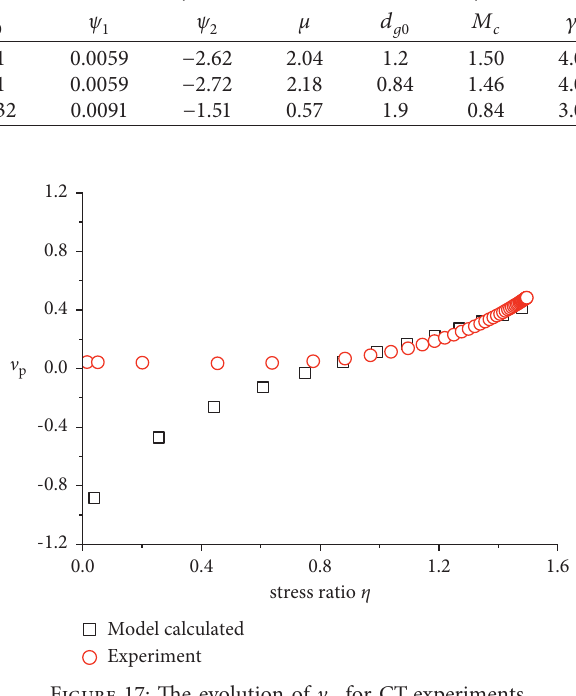
p for CT experiments.